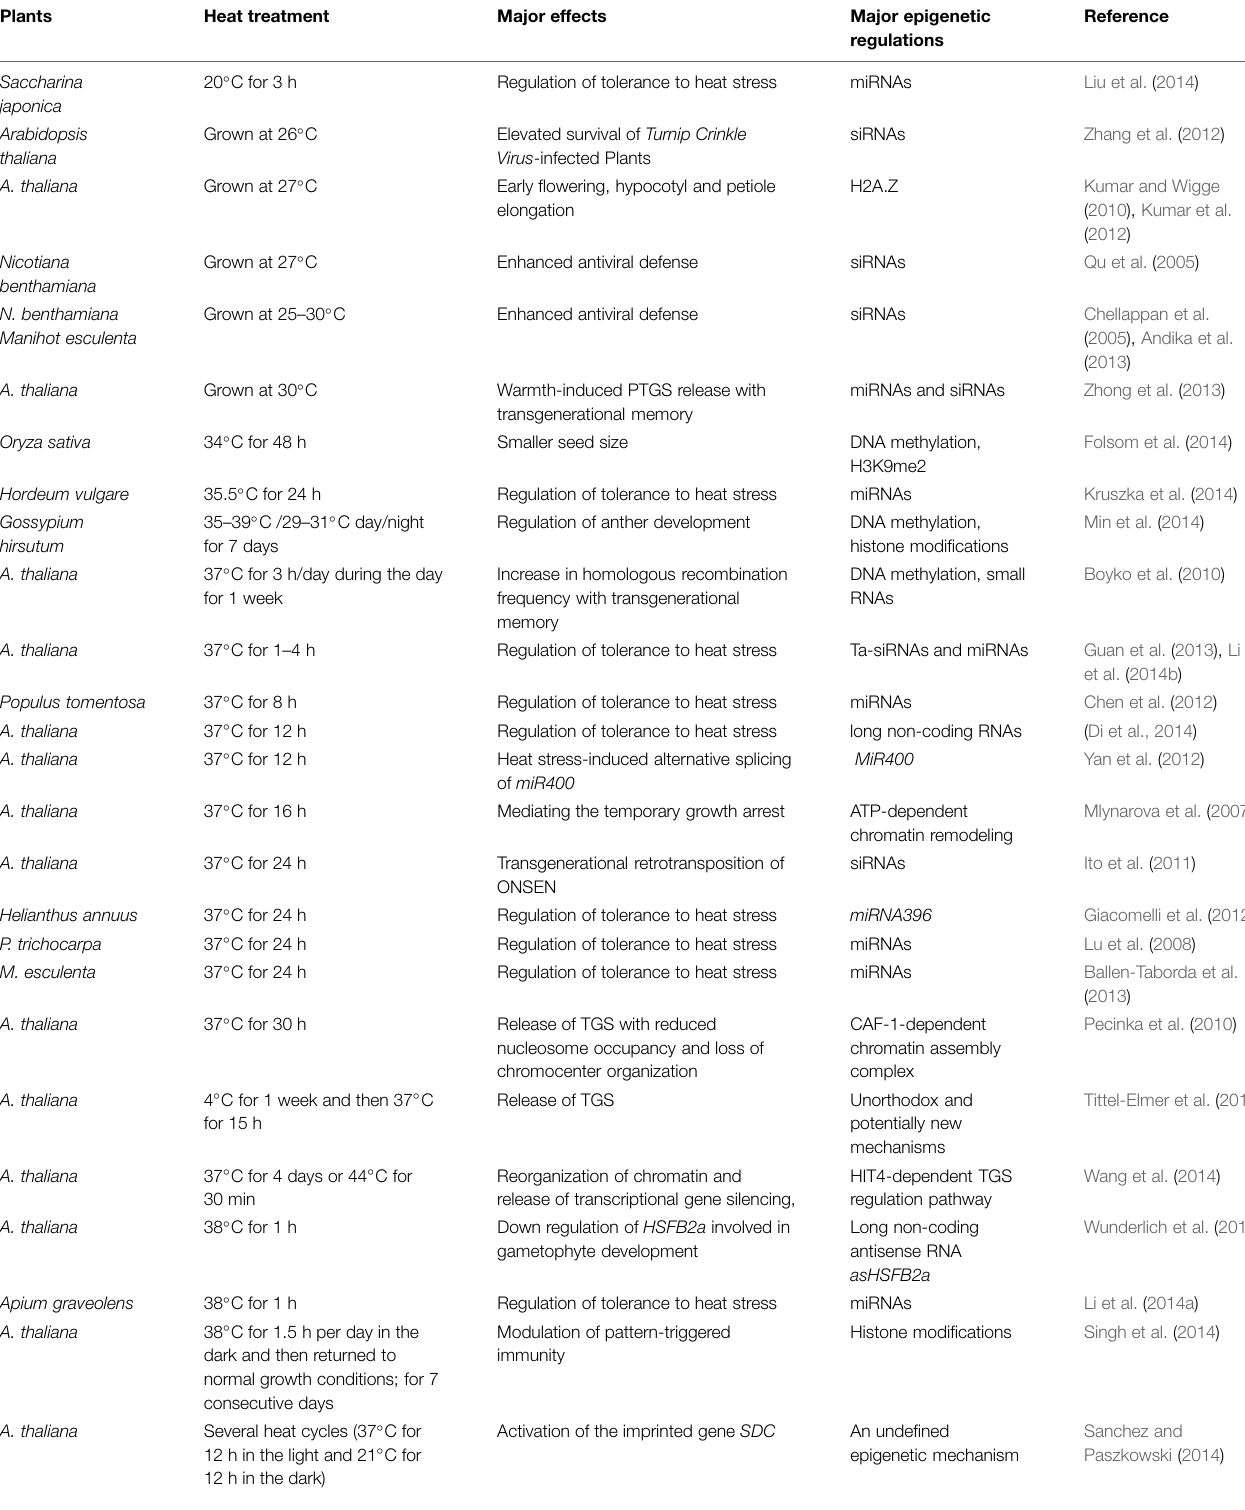
TABLE 1 | Different epigenetic regulations involved in different heat responses.